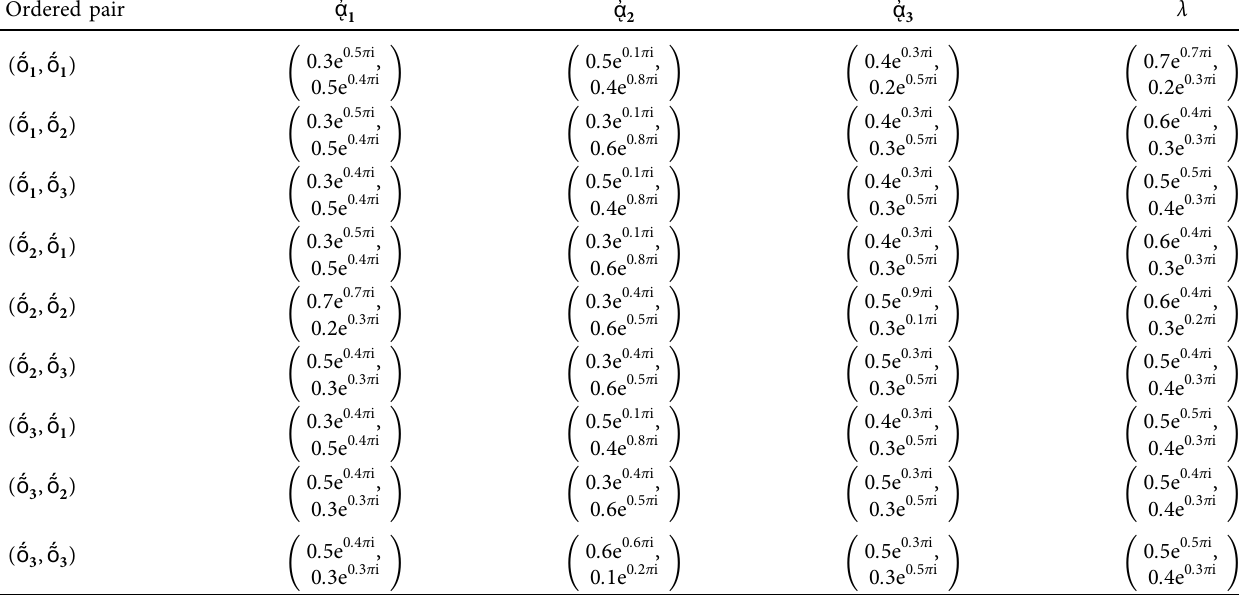
Table 6: Cartesian product.